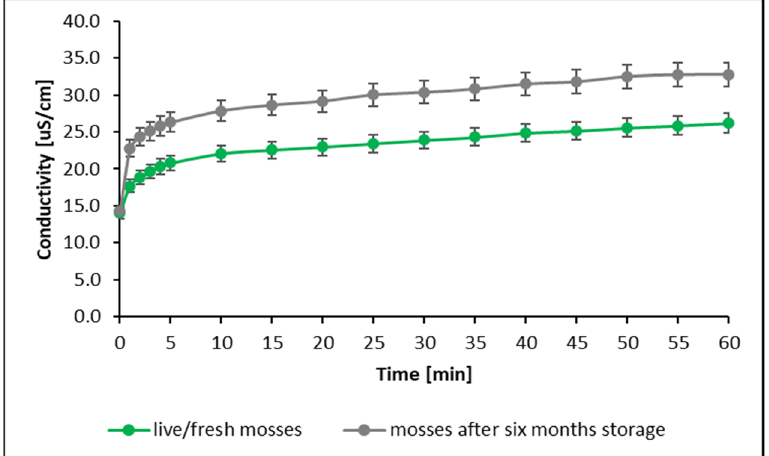
Figure 2. Conductivity changes during the process of Cu sorption on the moss P. schreberi (mosses stored in the laboratory for 6 months were used for the study).